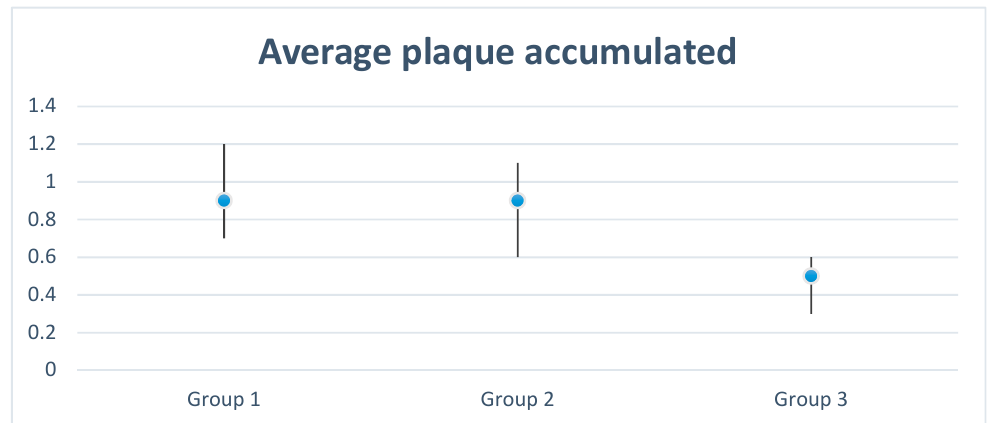
Figure 3. Average plaque accumulated at the end of monitoring on the healing abutments on each experimental group. Group 1: 0.9 (C.I. 0.7 – 1.2); Group 2: 0.9 (C.I. 0.6 – 1.1) and Group 3: 0.5 (C.I. 0.3 – 0.6).